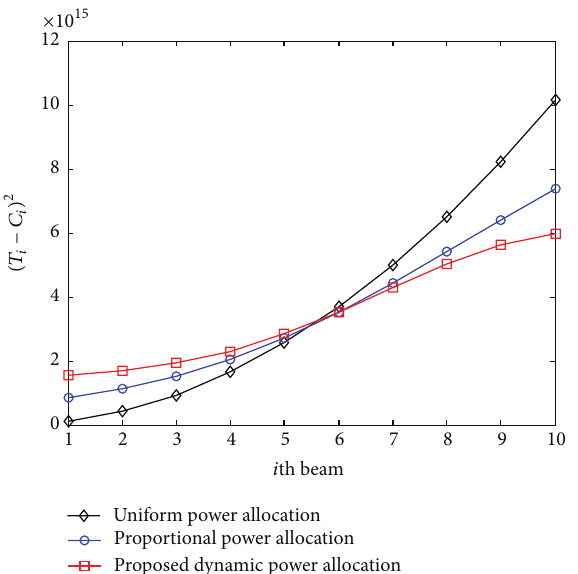
Figure 5: Distribution of the squared difference between the traffic demand and the capacity allocated to each beam, for the three algorithms in Scenario